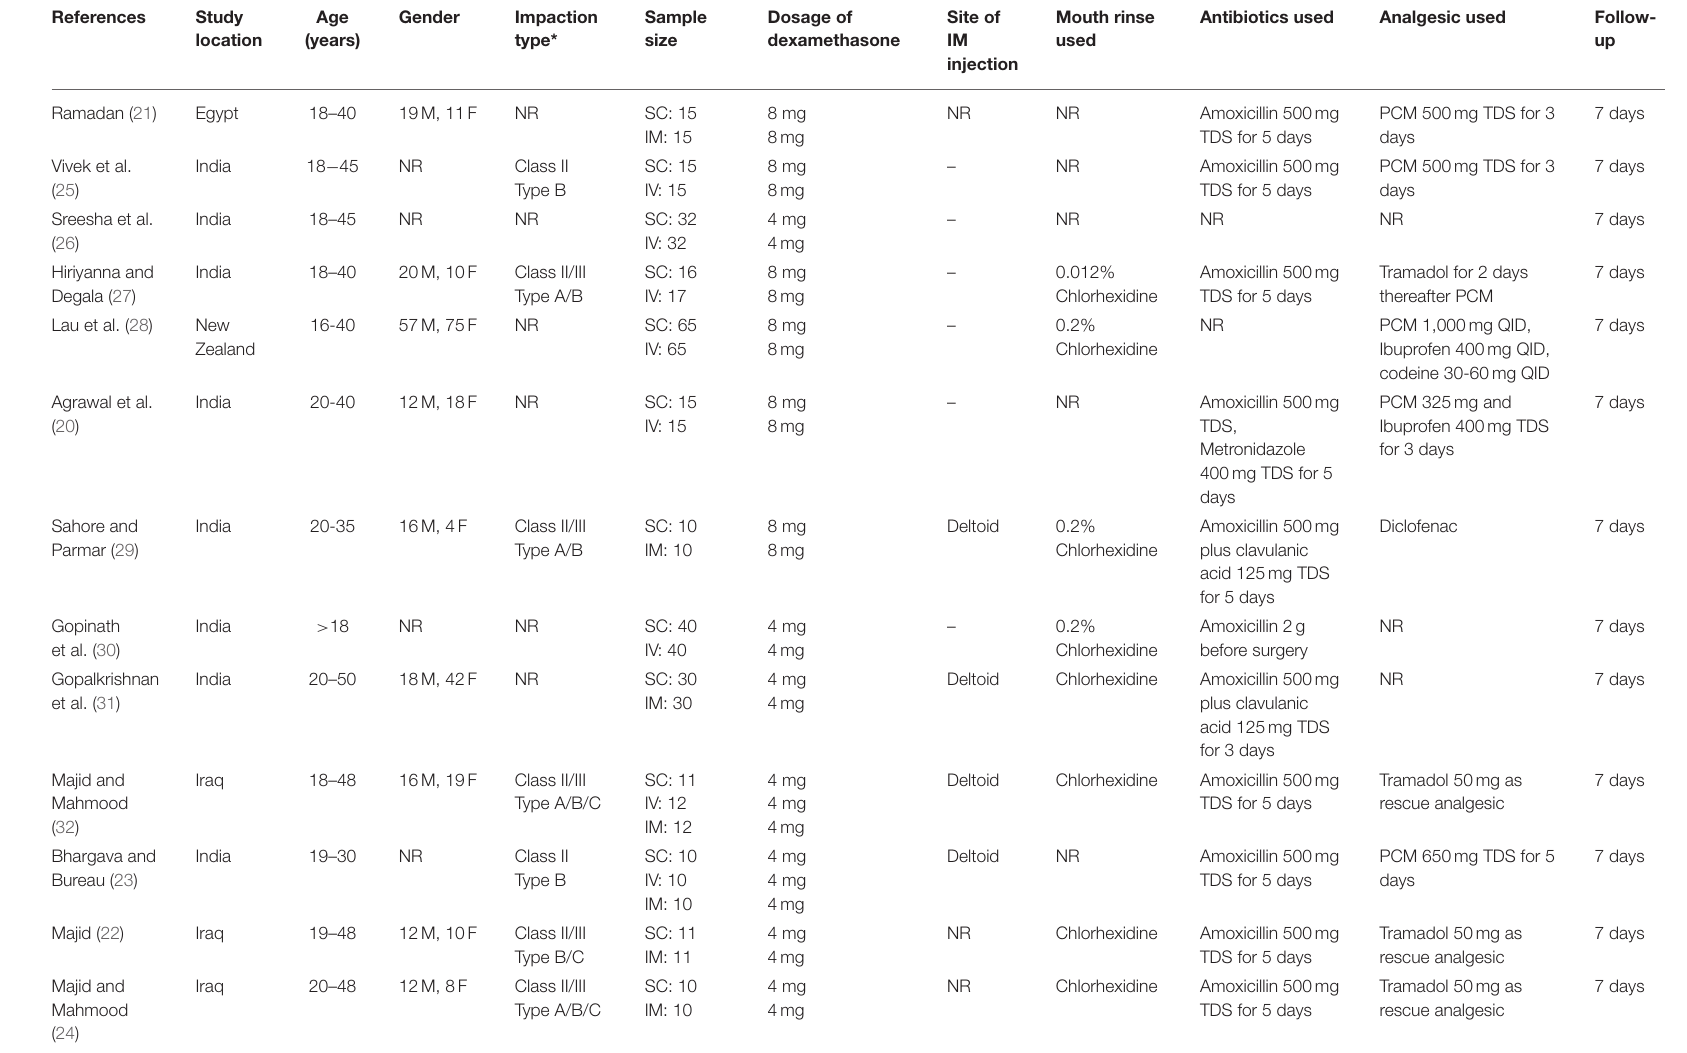
TABLE 1 | Details of included